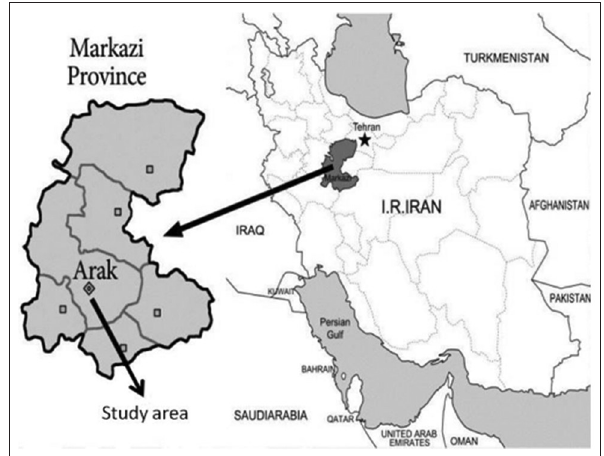
Figure-1: Map of study